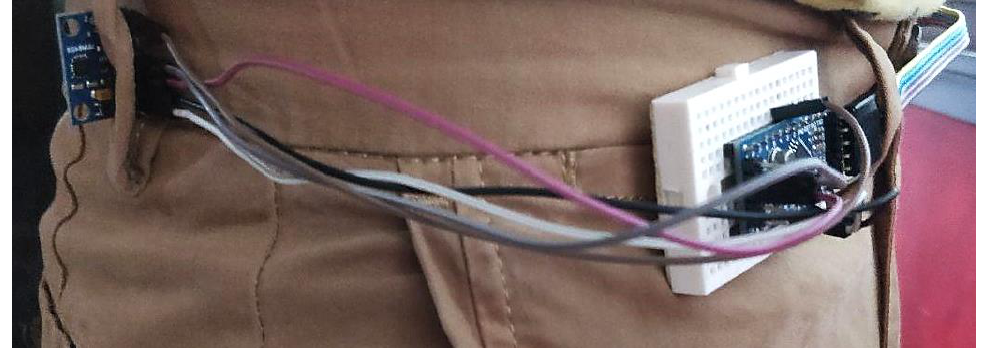
Figure 20. Positioning of the MMA8452Q acceleration sensor at the waist, in the belt loops, to keep it as firmly anchored as possible to the body and prevent the sensor from picking up fictitious accelerations. Table 6. Comparison of the number of steps calculated by the MMA8452Q accelerometer used as pedometer with the steps number counted manually by a second subject, during a walk at a normal pace.